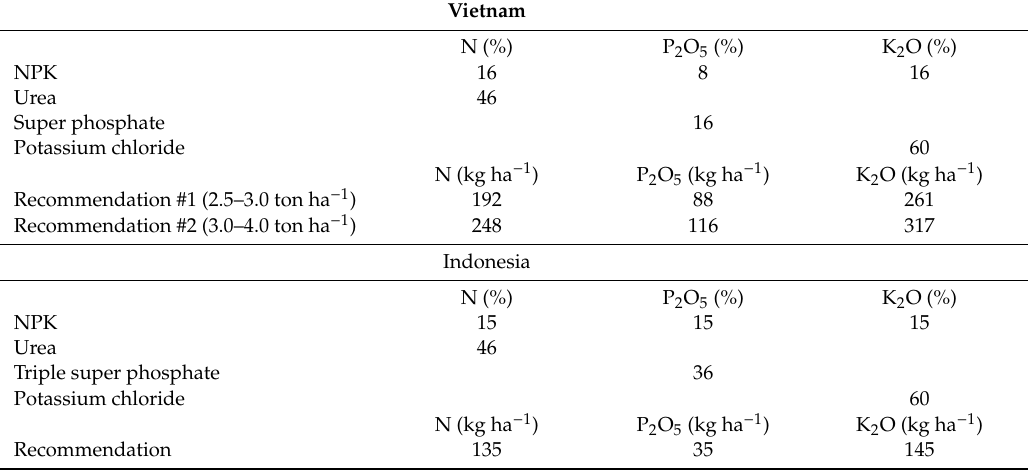
Table 3. Fertilizer types recorded in surveyed Robusta co ff ee farms in Vietnam and Indonesia and their nutrient contents. The recommended nutrient rates for two targeted yield levels in Vietnam [26,28–30] and mature trees (i.e., bearing fruits) in Indonesia [31] are